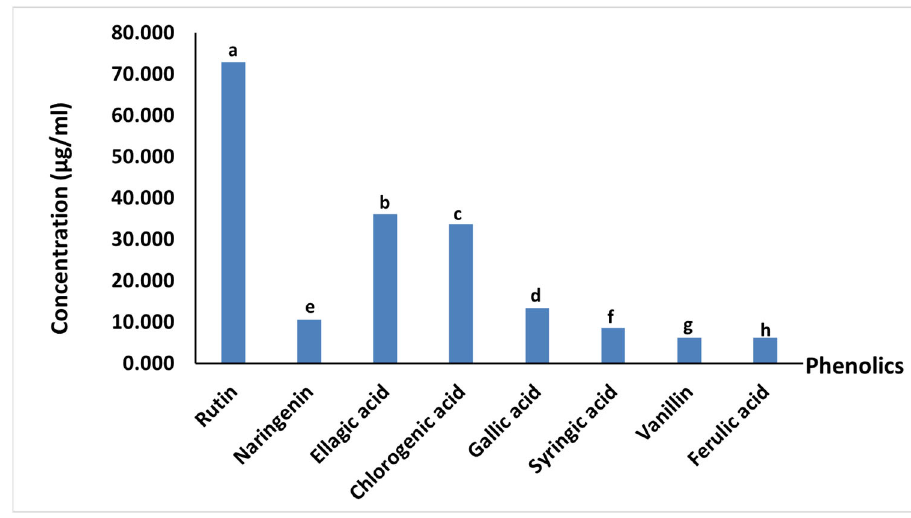
Figure 3. Phenolics profile of beetroot leaf–stem juice. Columns labeled with different letters are significantly different ( p < 0.05).